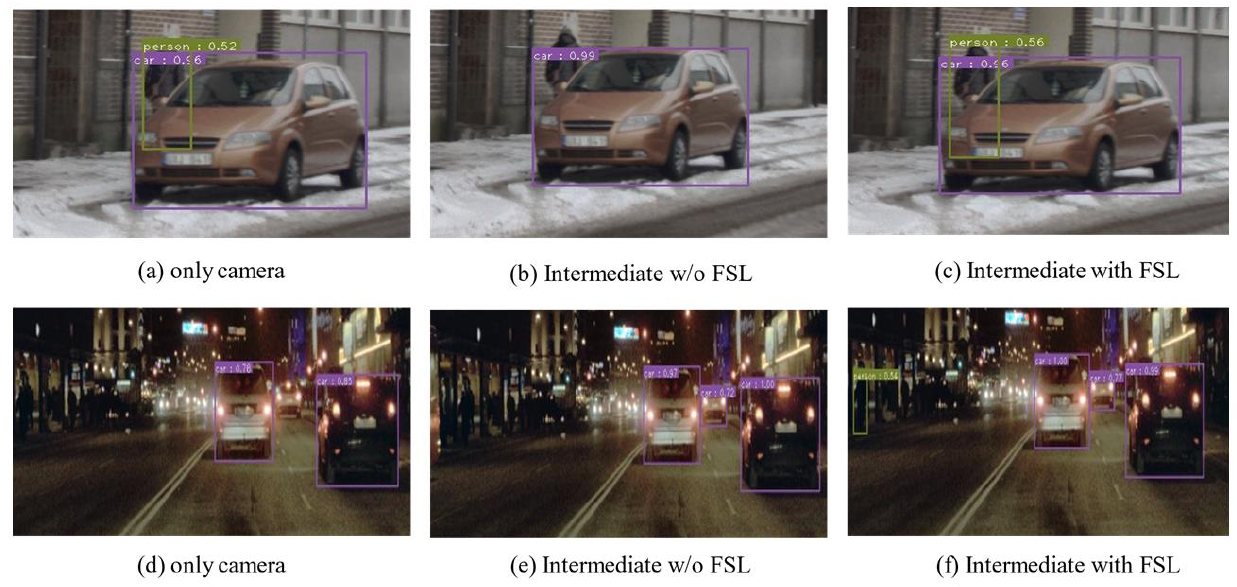
Figure 6. Clear/daytime, nighttime detection results. ( a – c ) Clear/daytime, only camera, intermediate w/o FSL, intermediate with FSL (proposed). ( d – f ) Clear/nighttime, only camera, intermediate w/o FSL, intermediate with FSL (proposed).